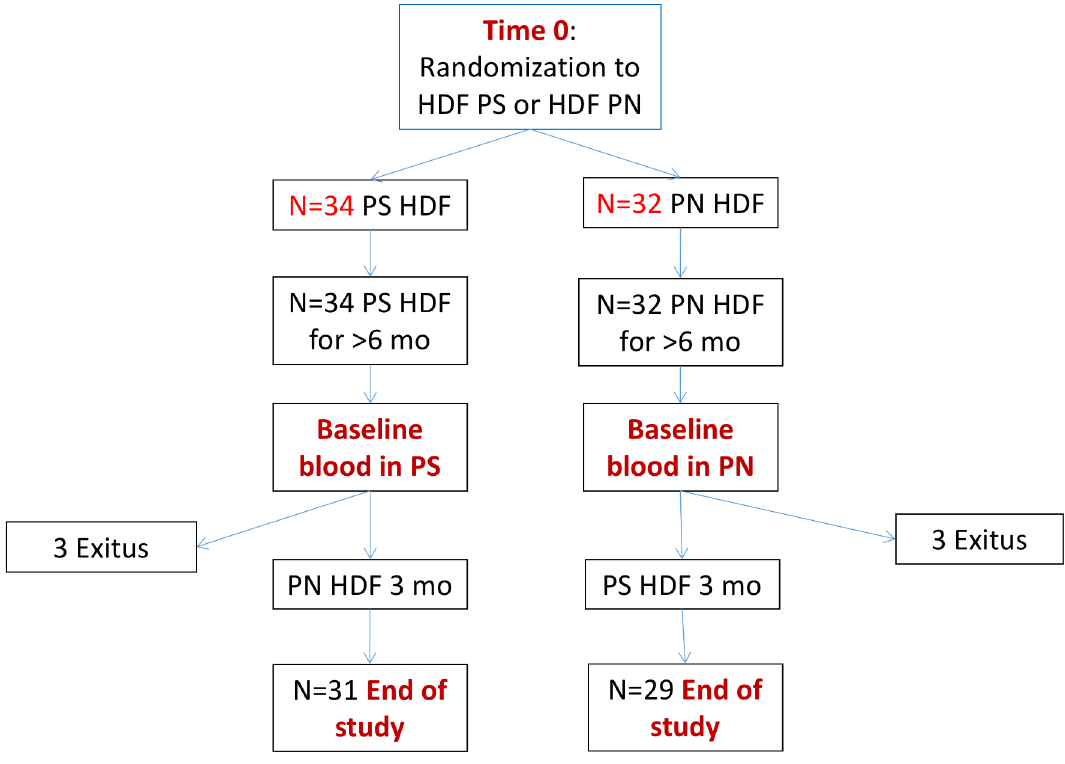
Fig 2. Patient flow